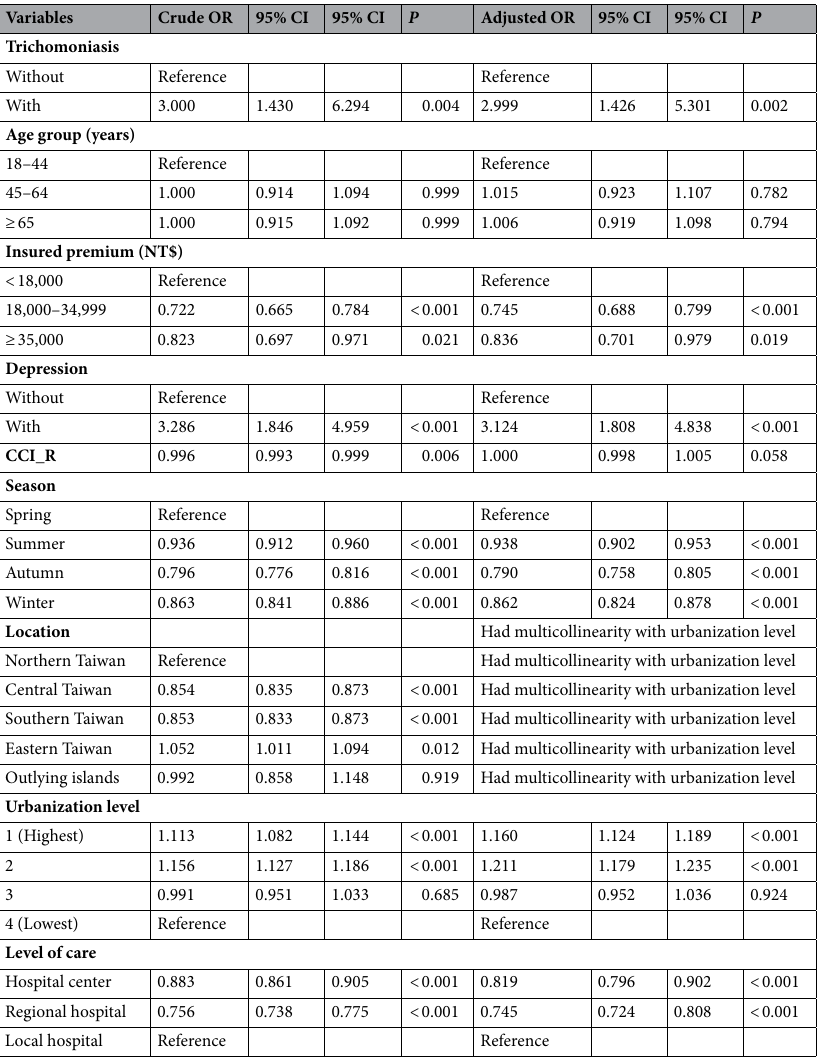
Table 2. Risk of BPH/prostate cancer and bladder cancer based on stated variables analyzed using multivariable logistic regression. OR odds ratio, CI confidence interval, Adjusted OR adjusted for variables listed in the